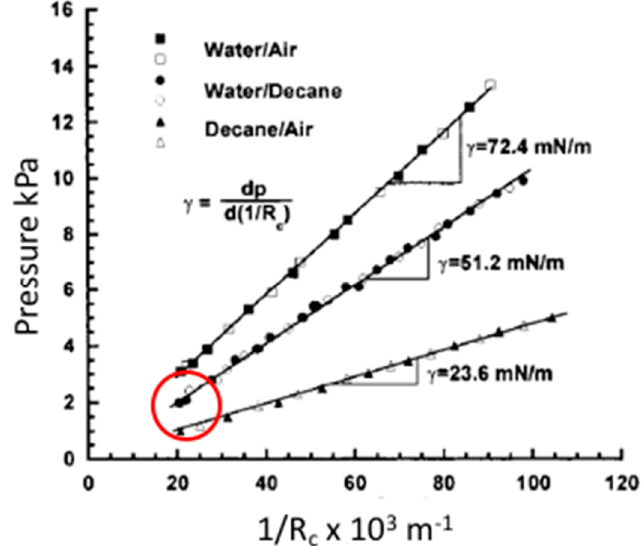
Figure 9. Plot of Equilibrium surface and interfacial tensions measured by the tapered micropipette manipulation technique. Data for applied micropipette pressure ∆ P (kPa) is plotted in this particular paper [9] against the reciprocal of the radius of curvature 1/ Rc ( × 10 3 m − 1 ) for Water/Air, Water/Decane and Decane/Air. Meniscus position was measured for both increasing pressure (hollow symbols) and decreasing pressure (solid symbols). As before (Figure 7), the surface tension was calculated from the slope of the plot. With permission from Elsevier [9]. The circled data correspond to the menisci shown in Figure 8, i.e., at the lowest pressures and largest radii of curvature. Table 1. Alkane and alkanol interfacial and surface tensions against water or air. Micropipette aspiration technique results are shown in bold letters. Data are at 20 ◦ C, except, micropipette aspiration technique results (23 ◦ C), γ OW of Decane (24.5 ◦ C), and both 1-Hexanol interfacial tensions (25 ◦ C). The literature data is obtained from [91,92] . Alkane